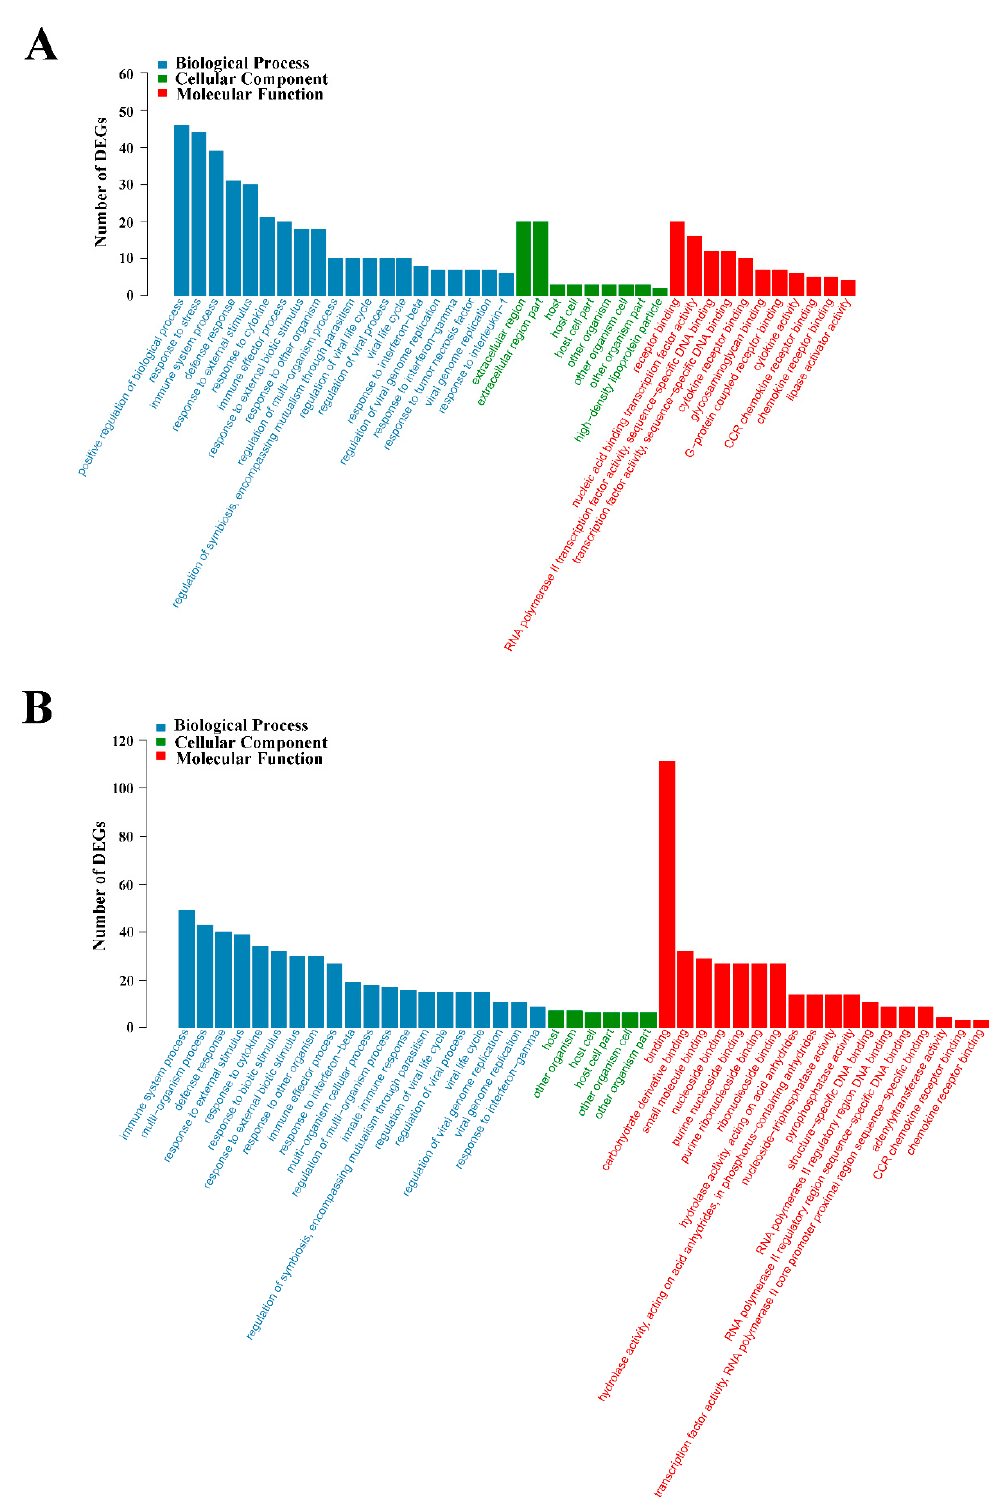
Figure 5. GO enrichment analysis of differentially expressed genes (DEGs) in L4h-vs-D4h ( A ) and L8h-vs-D8h ( B ). The X- and Y-axis represent the significantly enriched GO terms and the corresponding number of DEGs, respectively.